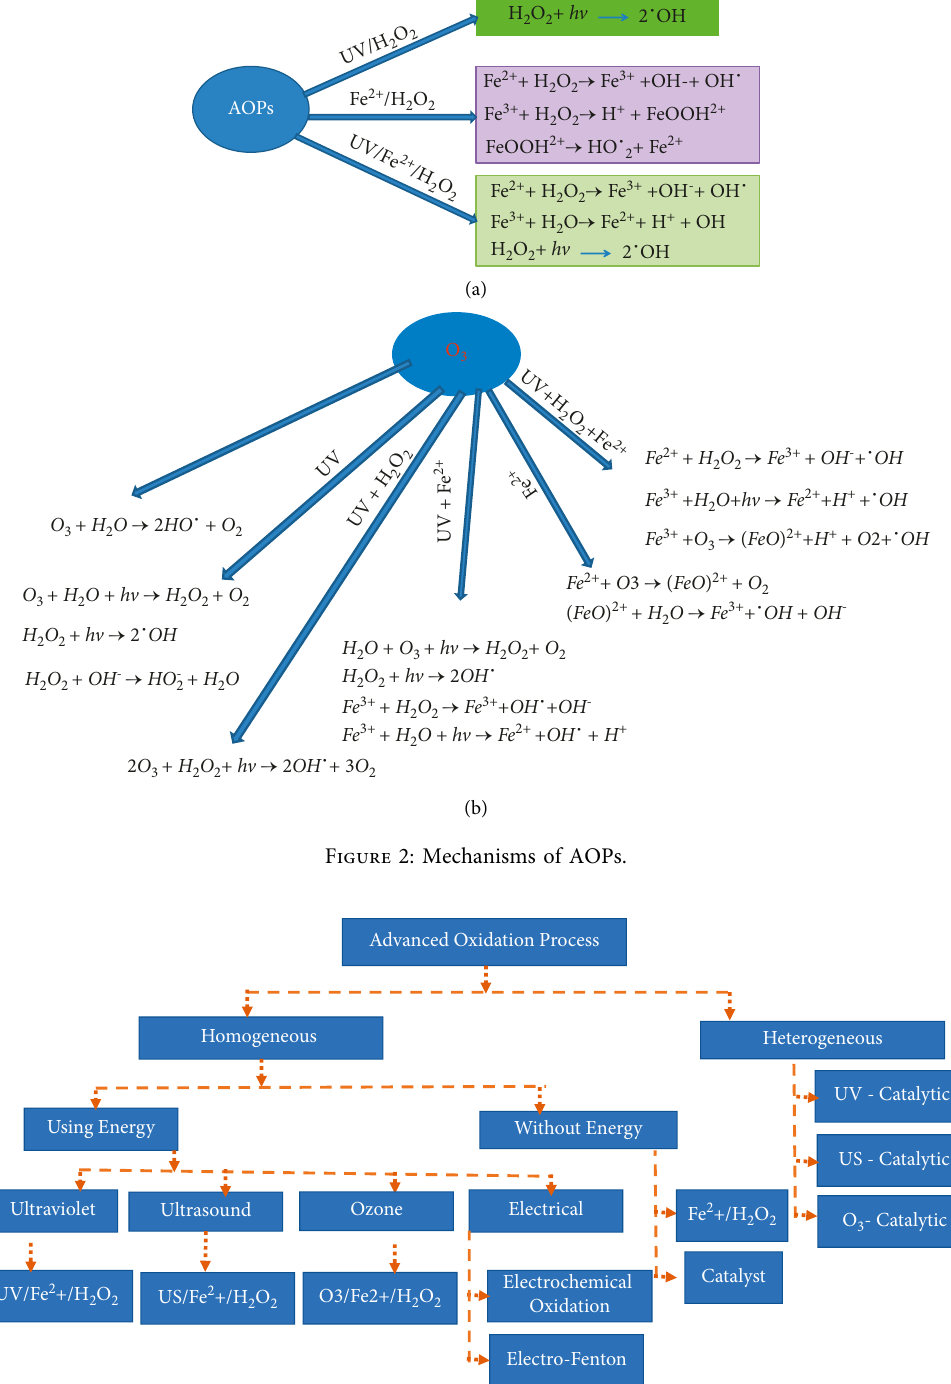
Figure 3: Types of advanced oxidation